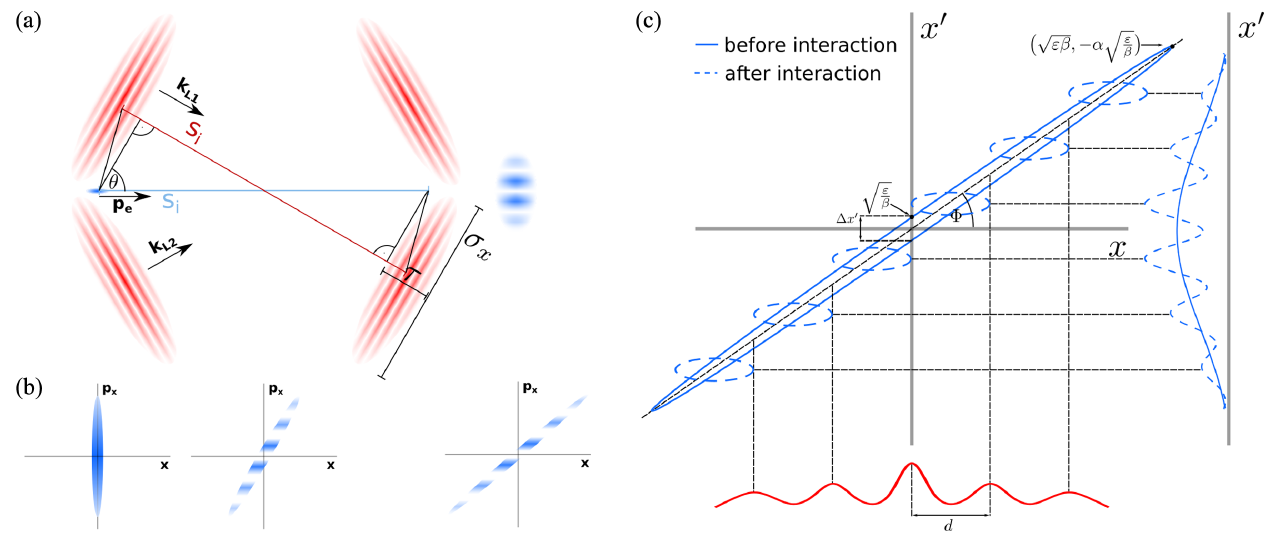
FIG. 1. (a) Schematic of the measurement setup showing two laser beams crossing under an angle 2 · ð 90 − θ Þ to form an interference pattern in the interaction region (Fig. 2). After the laser-electron interaction the imparted momentum modulation evolves into a transverse density modulation that can be observed on a downstream beam monitor screen and allows the e-beam waist size to be determined. Inclusion of a magnet behind interaction allows the emittance of monochromatic beam slices to be measured even for beams with a large projected energy spread. (b) Schematic of the beam momentum distribution at the waist, the interaction point and after free space propagation (from left to right). (c) Transverse electron phase space before (solid) and after laser-electron interaction (dashed). The red line indicates the intensity profile of the two interfering laser beams at the corresponding transverse position x at the interaction point. The ponderomotive force shifts the transverse momentum of the electrons. For an optimum laser intensity the momentum transfer is matched to the gradient of the phase space and shifts particles from regions of high laser intensity to regions of low intensity highlighted by the dashed